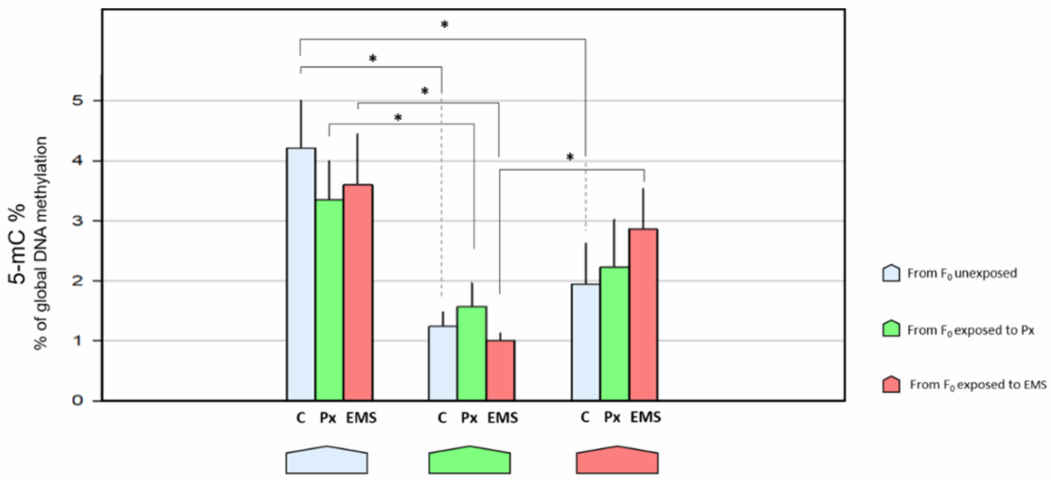
Figure 4. 1—Global Figure 4.